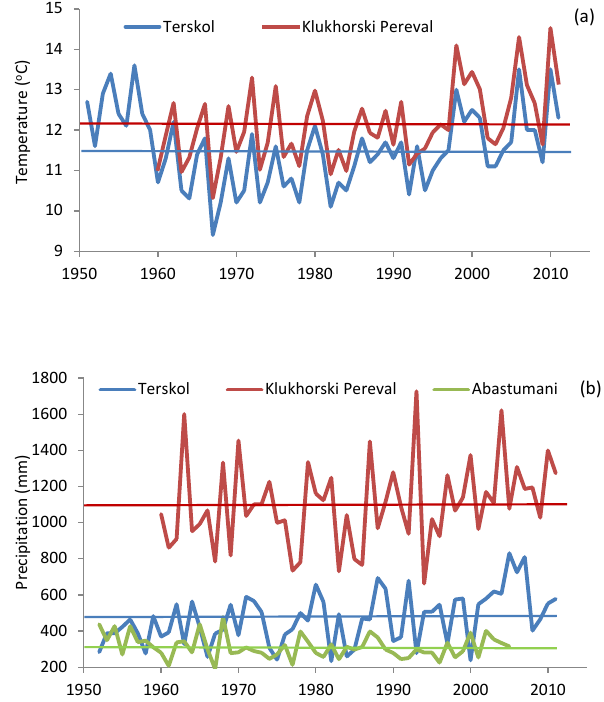
Figure 6. (a) JJA temperature and (b) October–April precipitation for Abastumani, Klukhorski Pereval and Terskol stations. Horizon- tal lines show record averages for each